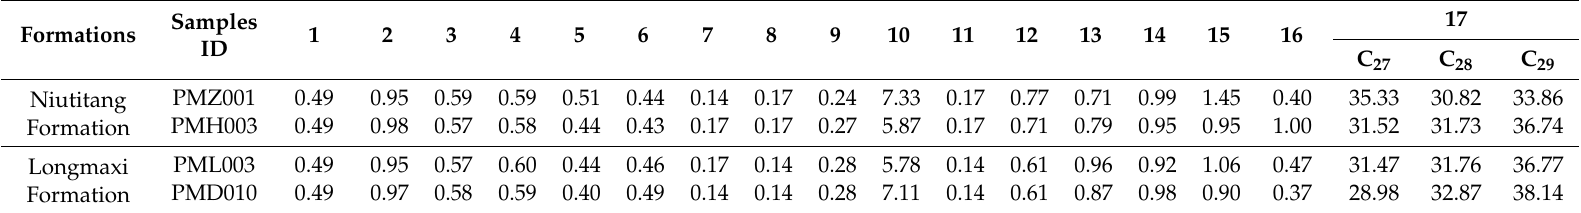
Table 5. Parameters of terpanes and